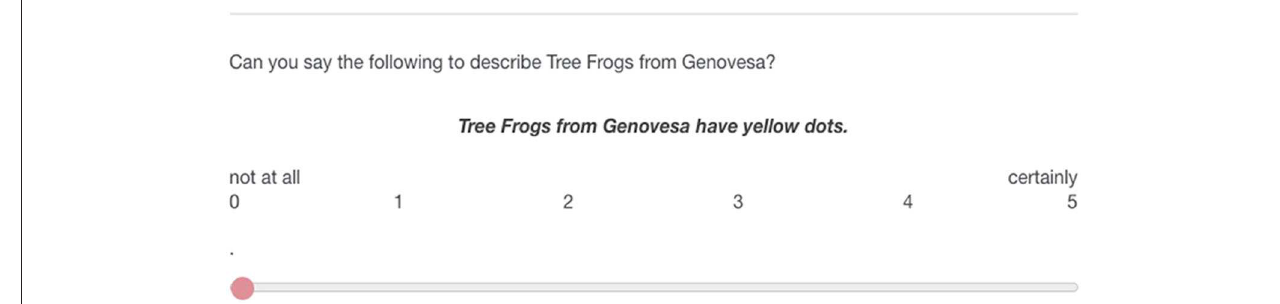
FIGURE 3 | Example question from the